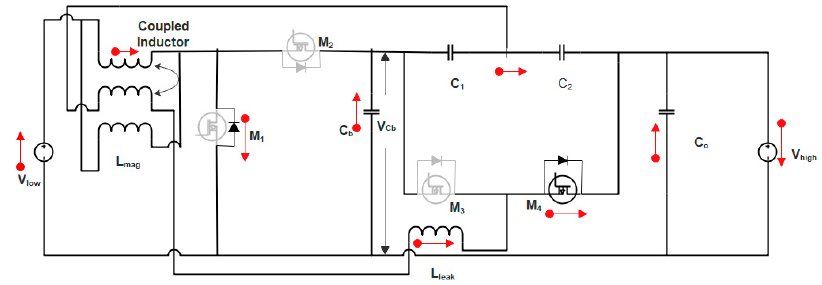
Figure 3. Equivalent circuit for mode I.